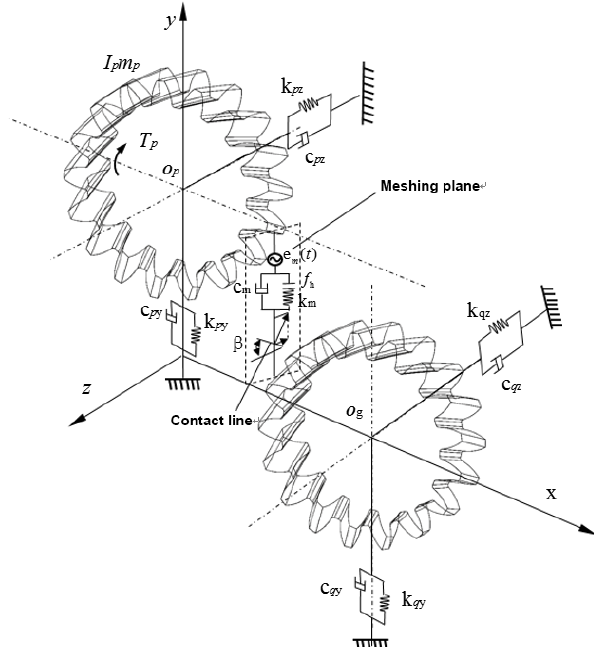
Figure 1. Three-dimensional vibration model of gear